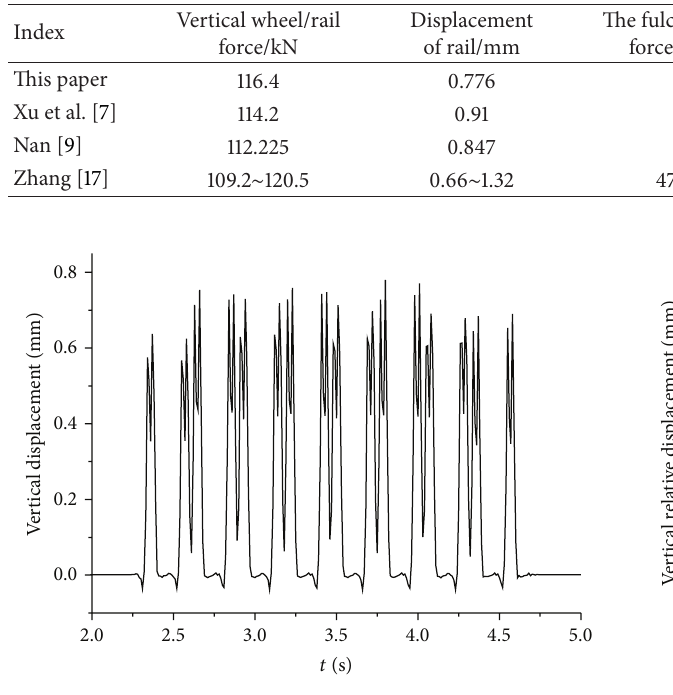
Figure 6: Time history of vertical displacement of rail.